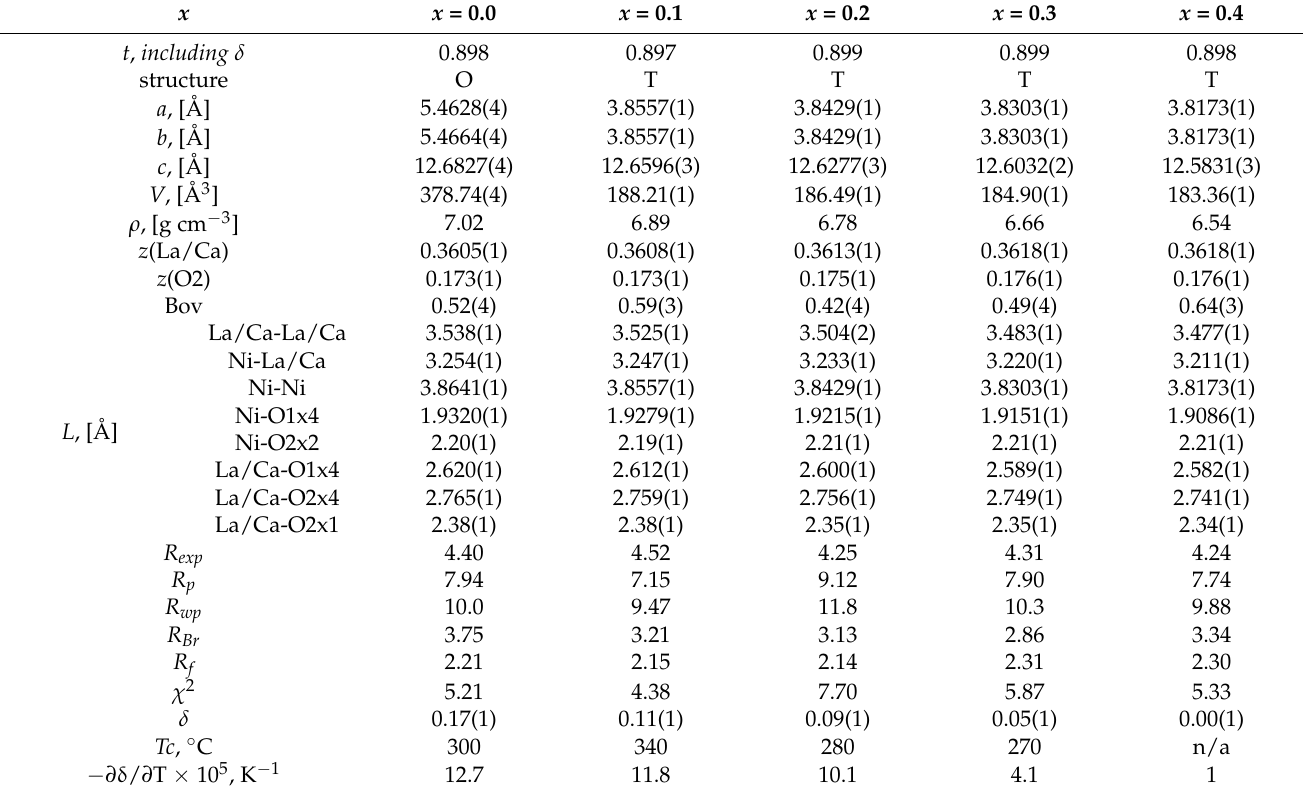
Table 1. Profile features, structural parameters and interatomic distances for La 2 − x Ca x NiO 4+ δ samples according to the X-ray diffraction (XRD) and thermogravimetric analysis (TGA) data. x x =